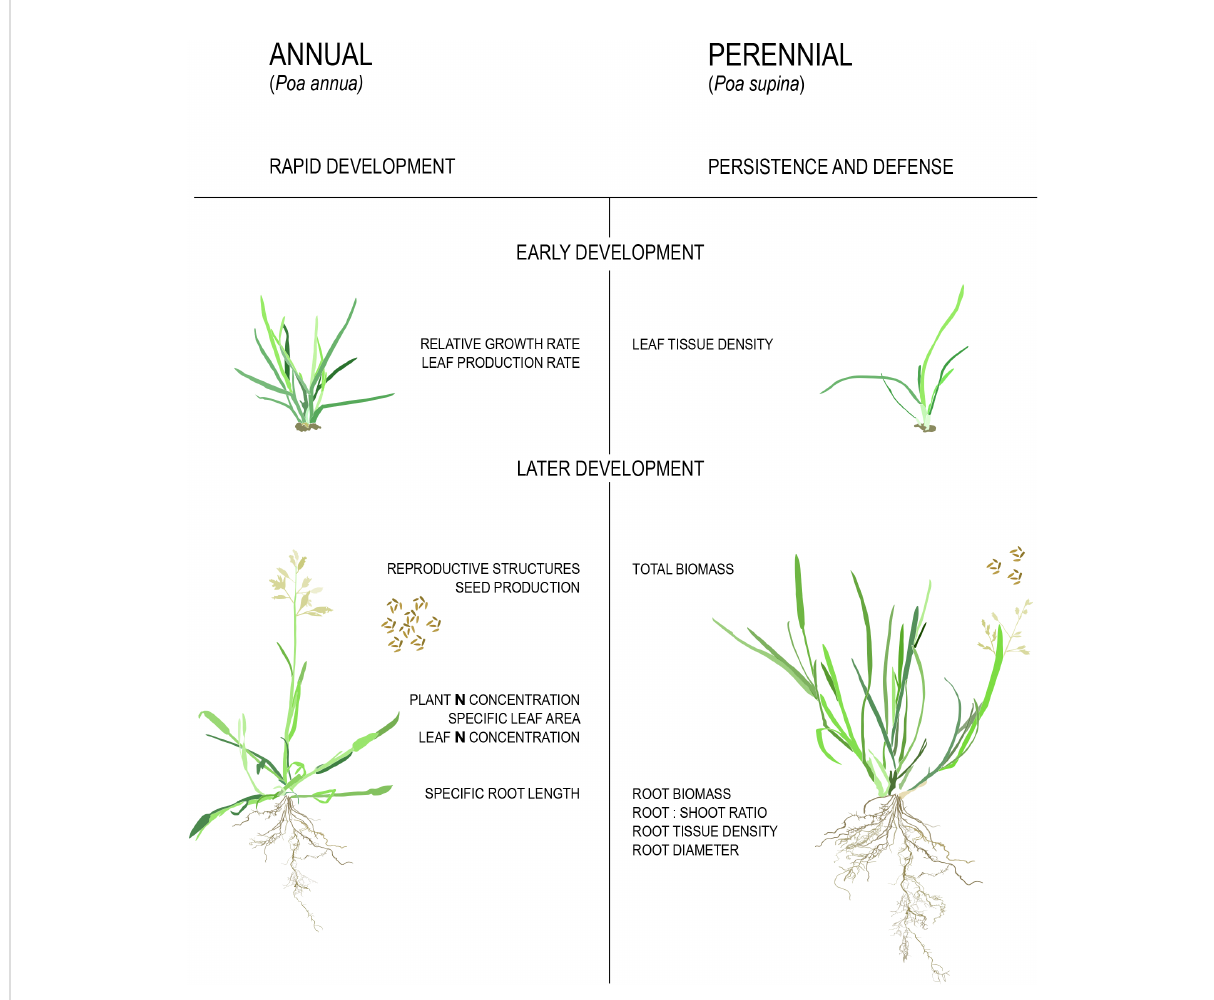
FIGURE 3 Physiological differences between annual and perennial plants. Traits listed in the fi gure are higher/larger in the respective